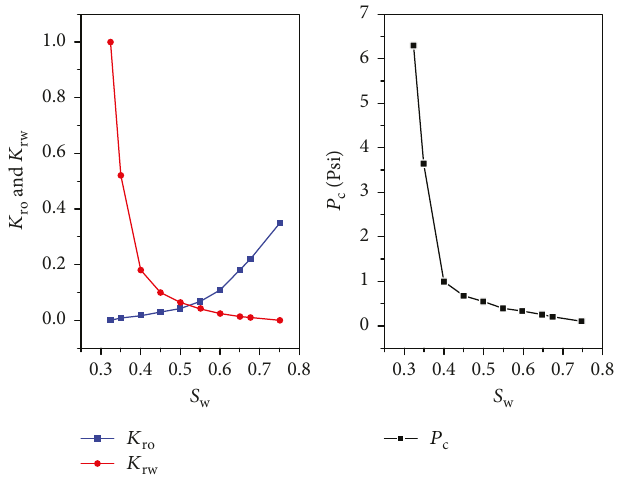
Figure 4: The gas/water relative permeability curve and capillary